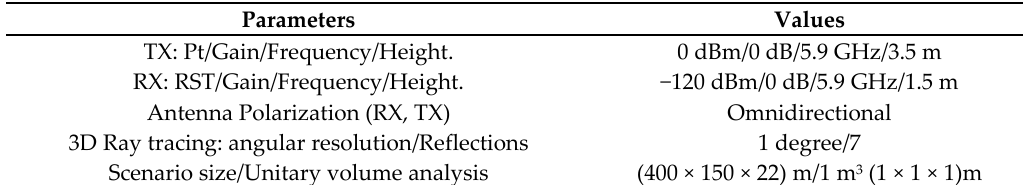
Figure 1. Urban scenario where, ( a ) is a google map aerial view, ( b ) is a 3D schematic frontal view and ( c ) is 2D aerial view. Table 2. Simulation parameters.